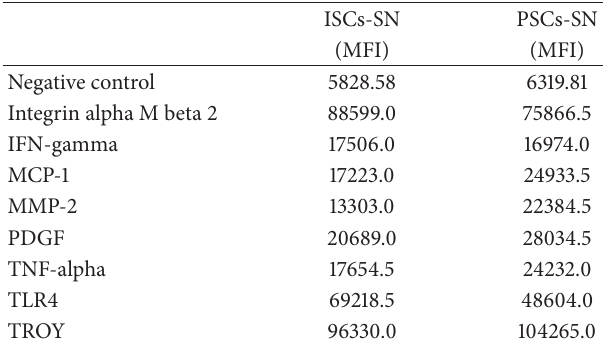
Table 2: Cytokines were highly expressed in both ISC-SN and intensity (MFI) using RayBio Biotin Label-Based Rat Antibody Array 1 assay. MFI ≥ 1.5-fold of negative control was considered as highly